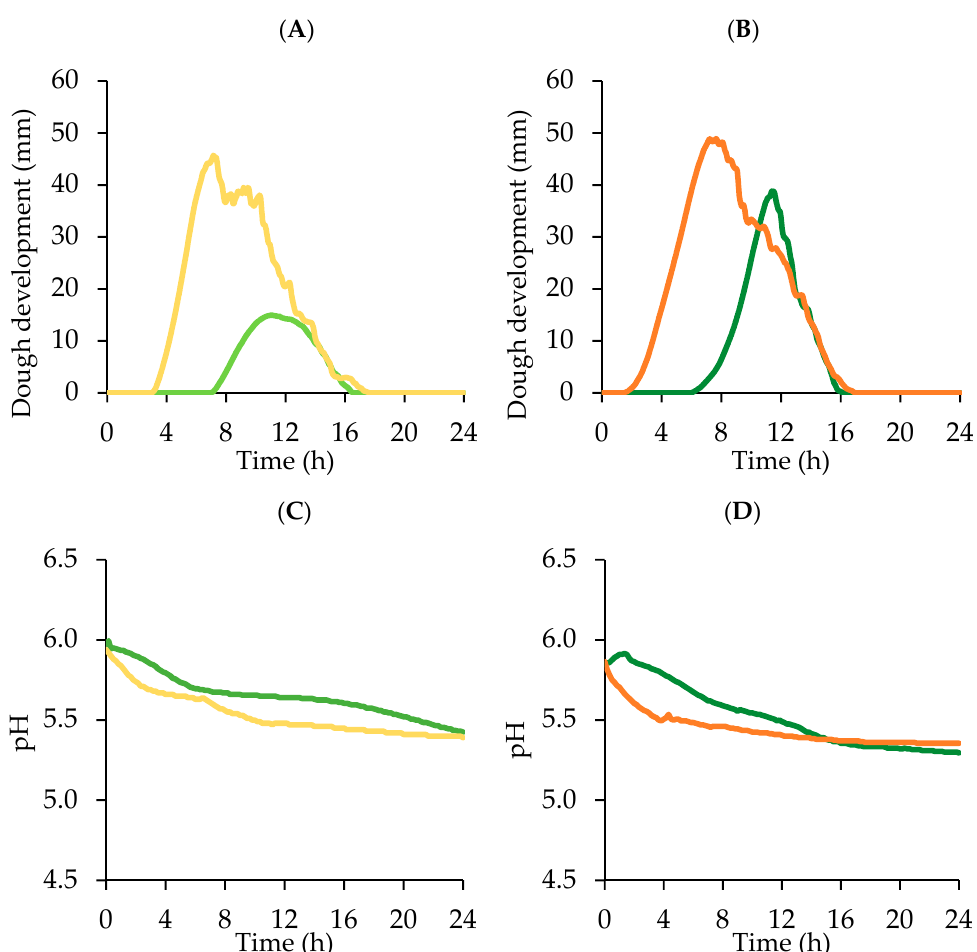
Figure 3. Dough development ( A , B ) and pH decrease ( C , D ) of doughs leavened for 24 h at 26 °C by Z. mobilis (Z, light green) or S. cerevisiae (S, light orange) without and with sucrose (Zs and Ss respectively, green and orange) addition (average curves of two technological replicates; relative standard deviation values ≤ 9%). See Table 1 for sample identifications and formulations.